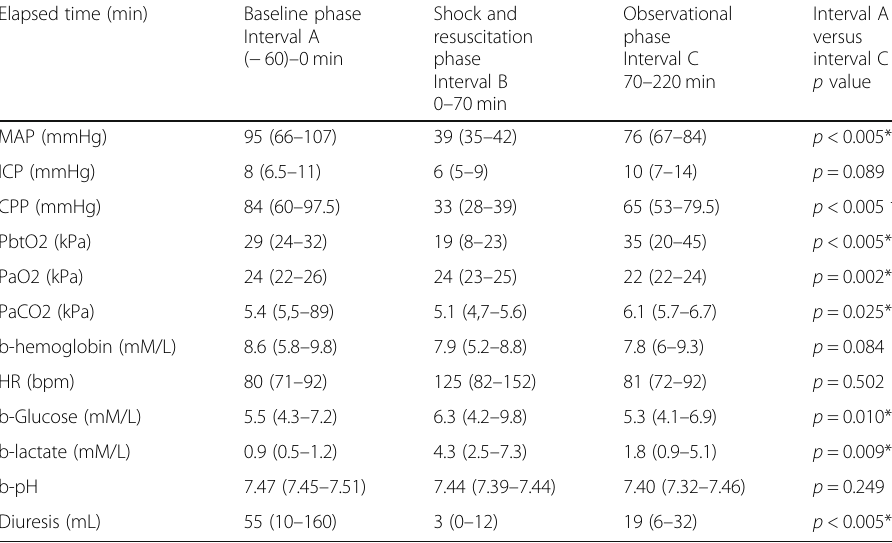
Table 1 General physiological and biochemical variables doing hemorrhagic shock. N = 9. Data are expressed as median levels (interquartile range) during the experimental protocol intervals A, B, and C. MAP mean arterial pressure, ICP intracranial pressure, CPP cerebral perfusion pressure, PbtO 2 brain tissue oxygenation. S indicates start of hemorrhage. Time 0 indicates achievement of MAP equal 40 mmHg. Test statistics made with mixed effect model Elapsed time